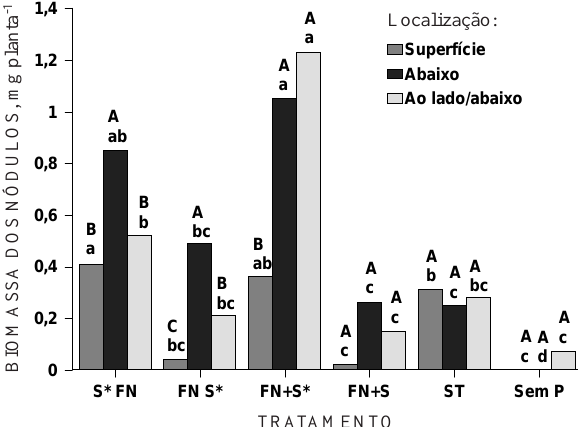
Figura 1. Biomassa dos nódulos em jacatupé nos tratamentos FN revestindo o enxofre inoculado com Acidithiobacillus (FN S*), FN revestido com S inoculado com Acidithiobacillus (S* FN), mistura FN com S inoculado com Acidithiobacillus (FN + S*), mistura FN com S sem Acidithiobacillus (FN + S), superfosfato triplo (ST) e sem adição de fósforo (sem P) de acordo com a localização do adubo. Letras minúsculas comparam as médias dos diferentes tratamentos com adição de P em cada modo de localização do adubo; letras maiúsculas, cada tratamento com P nos diferentes modos de localização do adubo. C.V. % =